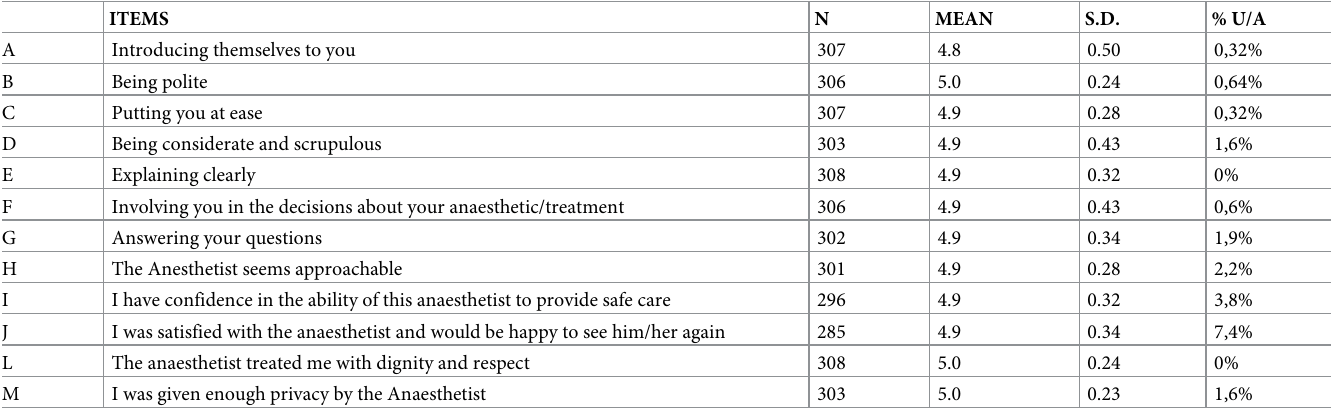
Table 4. Details about questions unable to assess rate, mean and standard deviation for patient